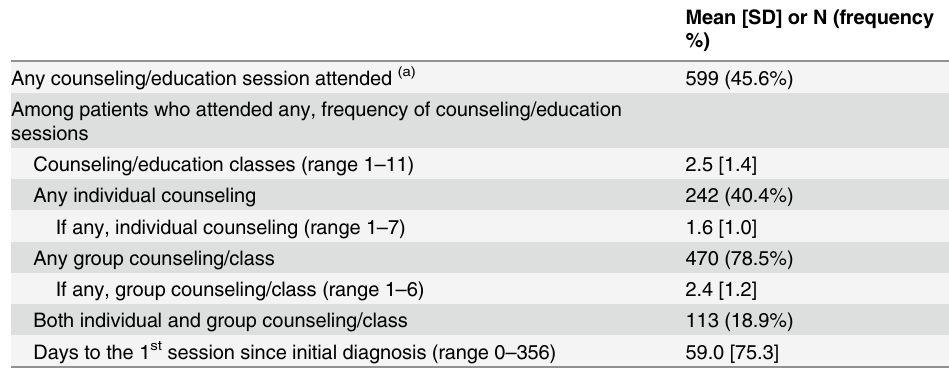
Table 2. Frequency of Counseling/Education Sessions.